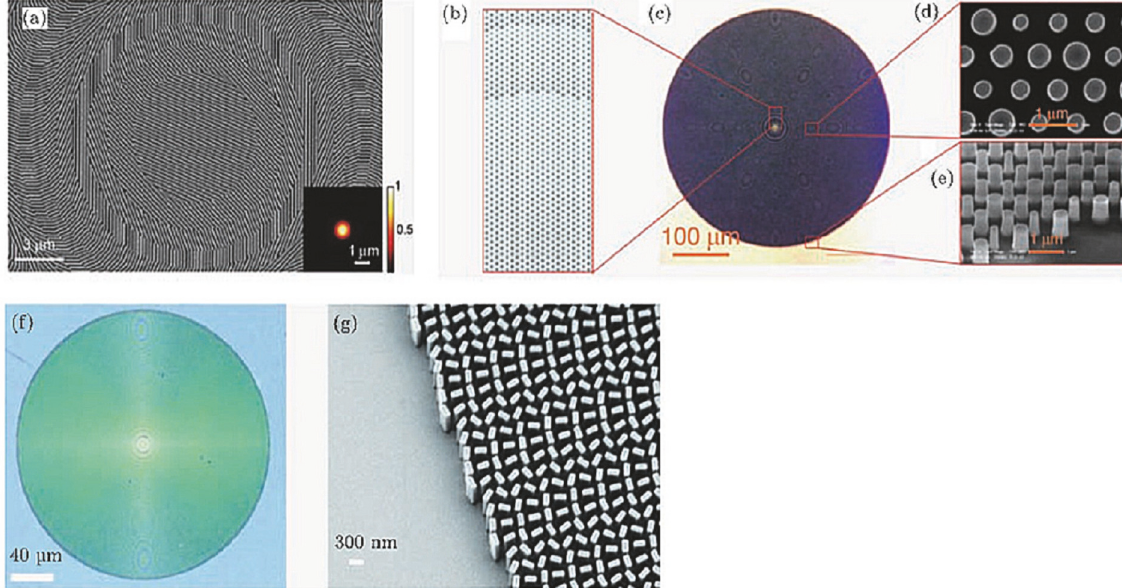
Figure 16: (a) All-media gradient metasurface lens. (b)-(e) High numerical aperture lenses; (f)-(g) visible light